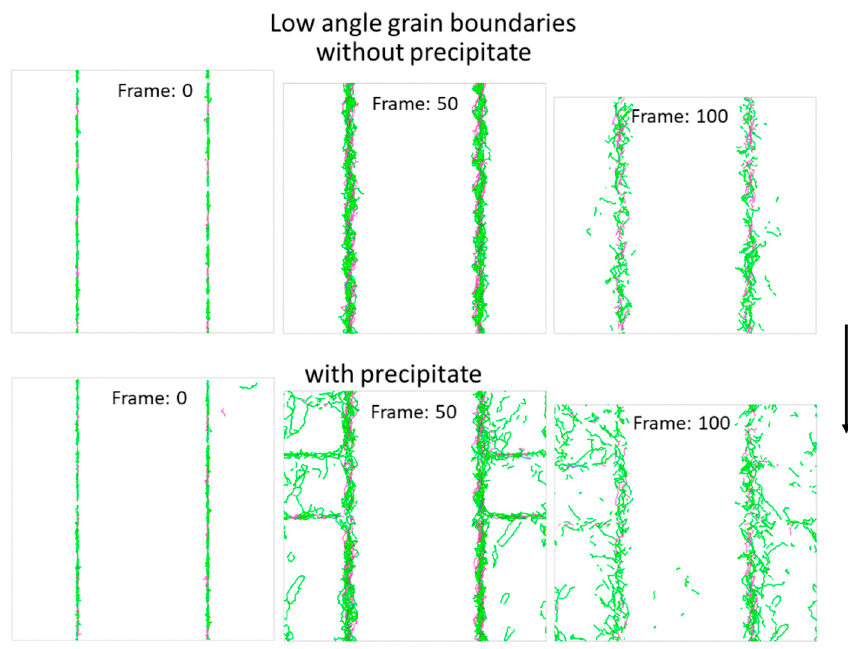
Figure 9. Evolution of defects during compression of grains with LABs (arrow indicates compression direction).